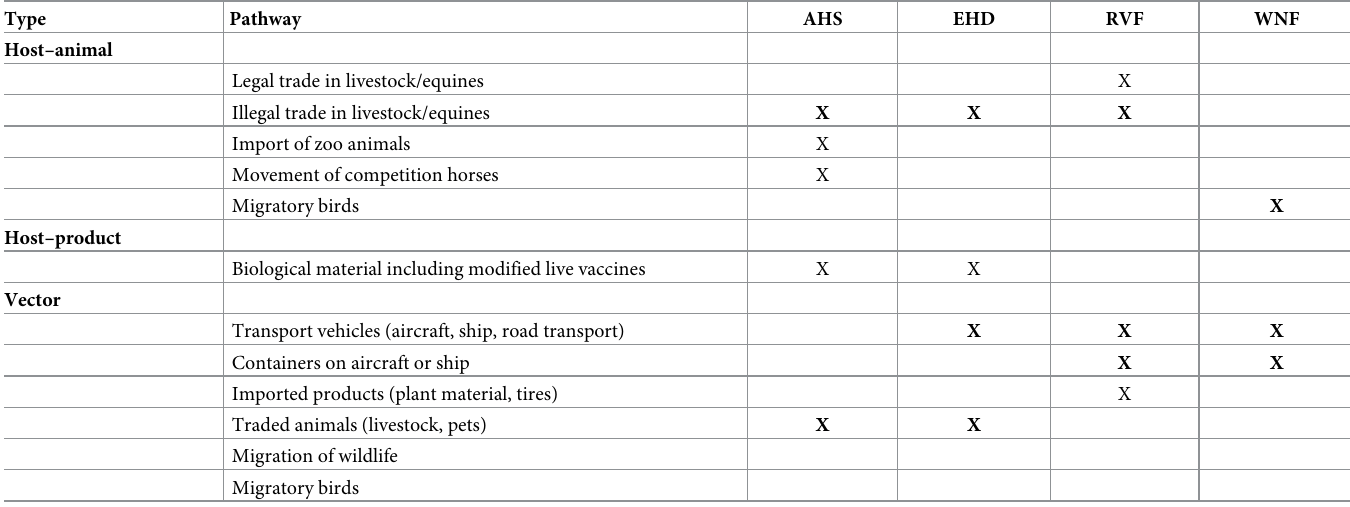
Table 3. Pathways entered into MINTRISK to assess the introduction risk of each